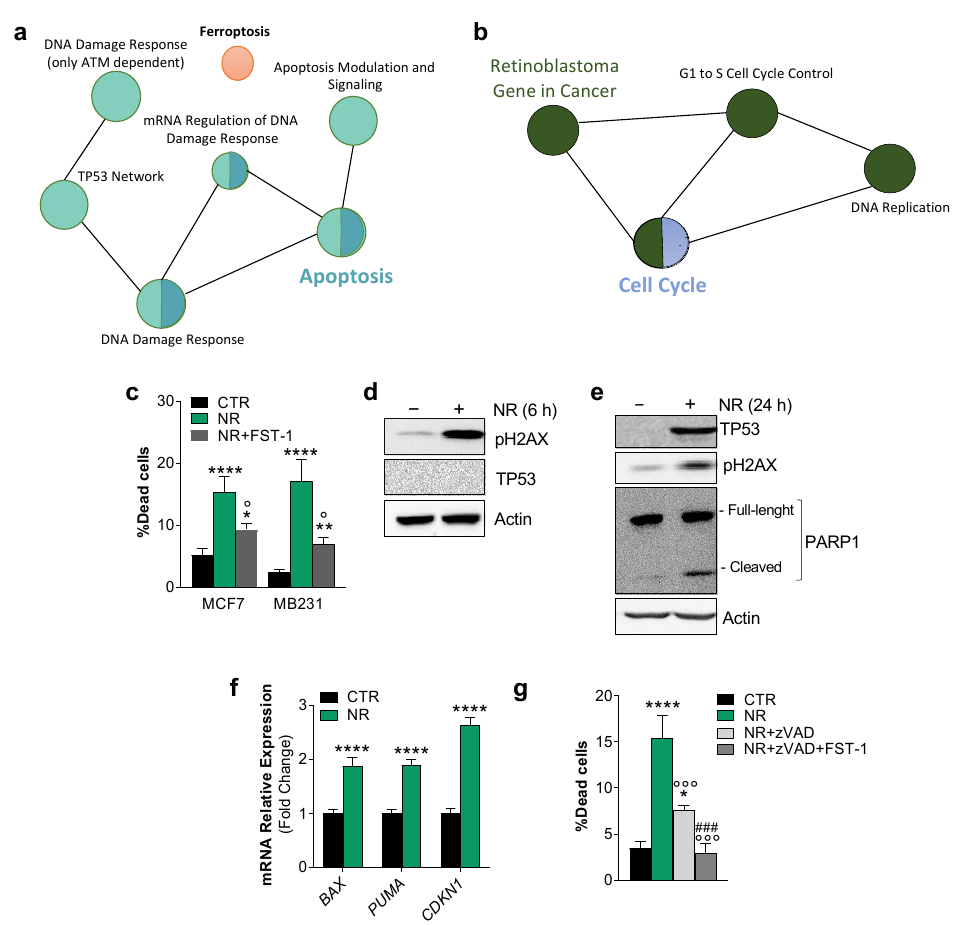
Figure 1. Breast cancer cells undergo both apoptosis and ferroptosis upon nutrient restriction. (a,b) Functional enrichment analysis of microarray data (GSE121378) using Cytoscape software. Wikipathways of the top 200 up-regulated ( a ) and down-regulated ( b ) genes (FC > 1.5, FC < 0.5; p < 0.05) are reported. ( c ) Percentage of dead breast cancer cells after 24 h nutrient restriction (NR: HBSS, 1 g/L glucose, 1% FBS) with or without 1 h pre-treatment with 5 μ M ferrostatin-1 (FST-1). ( d , e ) Western blot analysis of pH2AX, p53, and PARP-1 on MCF7 cells treated with NR. Actin was used as loading control. Immunoblots reported are representative of three independent experiments yielding similar results. ( f ) RT-qPCR analysis of the mRNA expression of p53 downstream genes BAX, PUMA, CDKN1. ( g ) Percentage of dead breast cancer cells after 24 h NR with or without 1 h pre-treatment with 10 µ M z-VAD-fmk (zVAD) and 5 µ M FST-1. Data are expressed as mean ± S.D. ( n = 3; **** p < 0.0001, ** p < 0.01, * p < 0.05, vs. CTR; ◦ p < 0.05, ◦◦◦ p < 0.001 vs. NR; ### p < 0.001 vs. NR and NR +